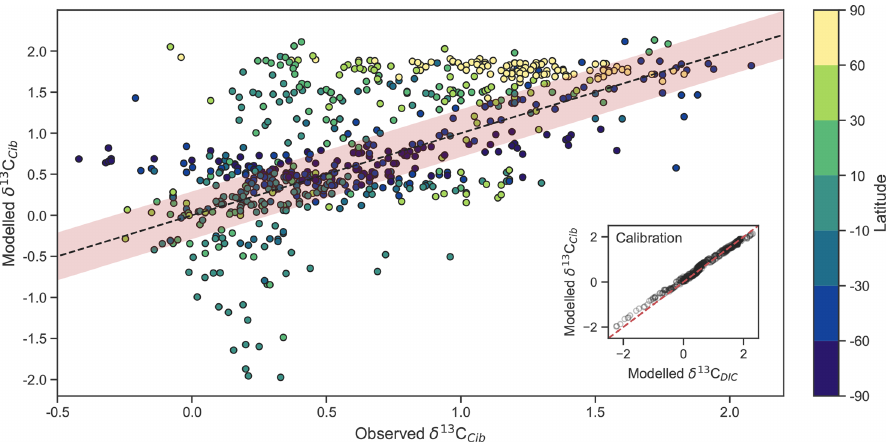
Figure 5. Measured versus modelled δ 13 C Cib ( N = 690) of CSIRO Mk3L-COAL coloured by latitude. Red shading about the 1 : 1 line is an estimate of the variability implicit in the relationship between δ 13 C Cib and δ 13 C DIC of Schmittner et al. (2017). The inset on the bottom right shows the effect of the calibration of Eq. (21). Table 4. Comparison of global and region mean δ 15 N NO between observations and model simulations. Model means are annual averages. 3 All data were regridded onto the CSIRO Mk3L-COAL grid space. The δ 15 N data (5330 measurements courtesy of the Sigman Lab, Princeton University) were binned into corresponding grid boxes and averaged for direct comparison, which reduced the data to 2532 points. More than one data point of δ 15 N may therefore contribute to each simulated